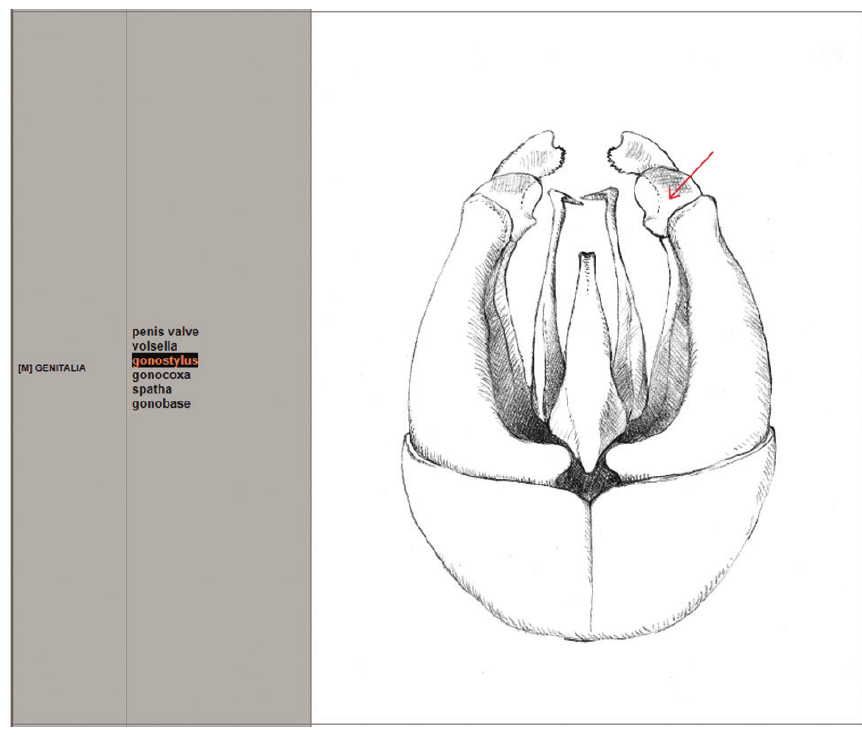
Figure 3. Interactive image window for morphology.